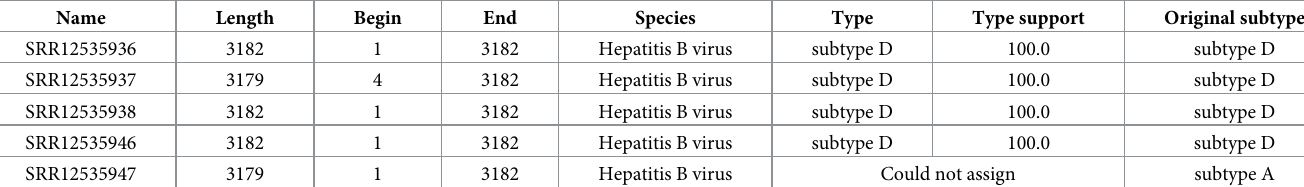
Table 4. Short result of the phylogenetic type classification of HBV samples by genome